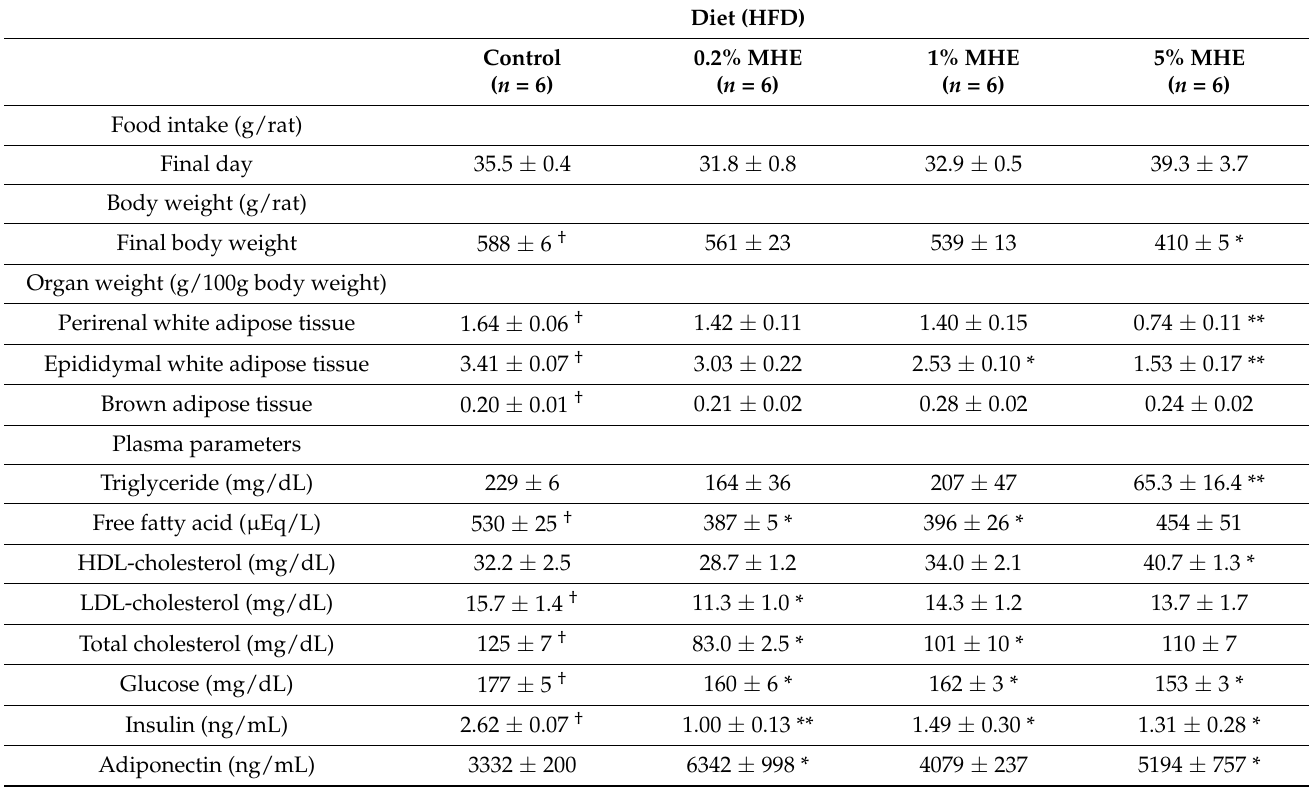
Table 6. Effects of MHE on physical and plasma parameters in HFD-fed rats after 10 weeks.